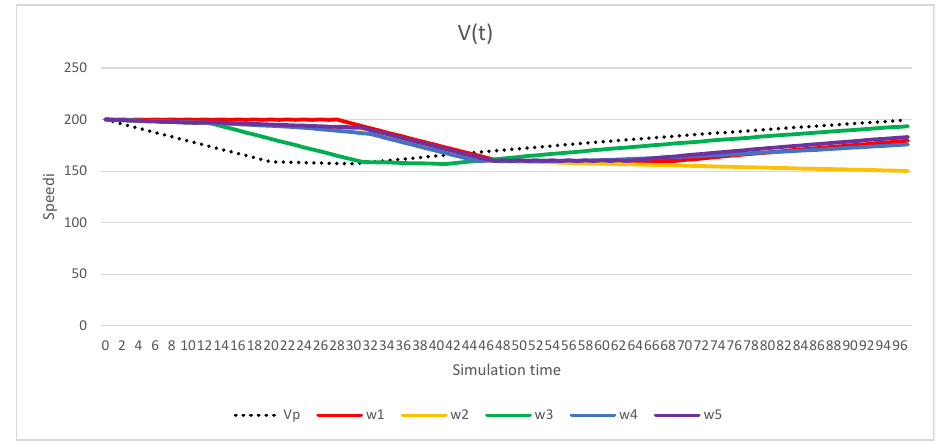
Figure 7. Velocity change V ( t ) in simulation by context 1 for distance D 0 = D gr = 2000 m.